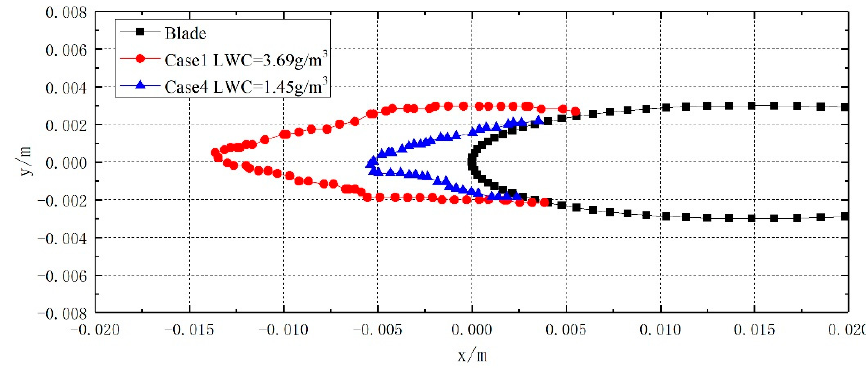
Figure 10. Comparison of ice shapes under different liquid water content (LWC).